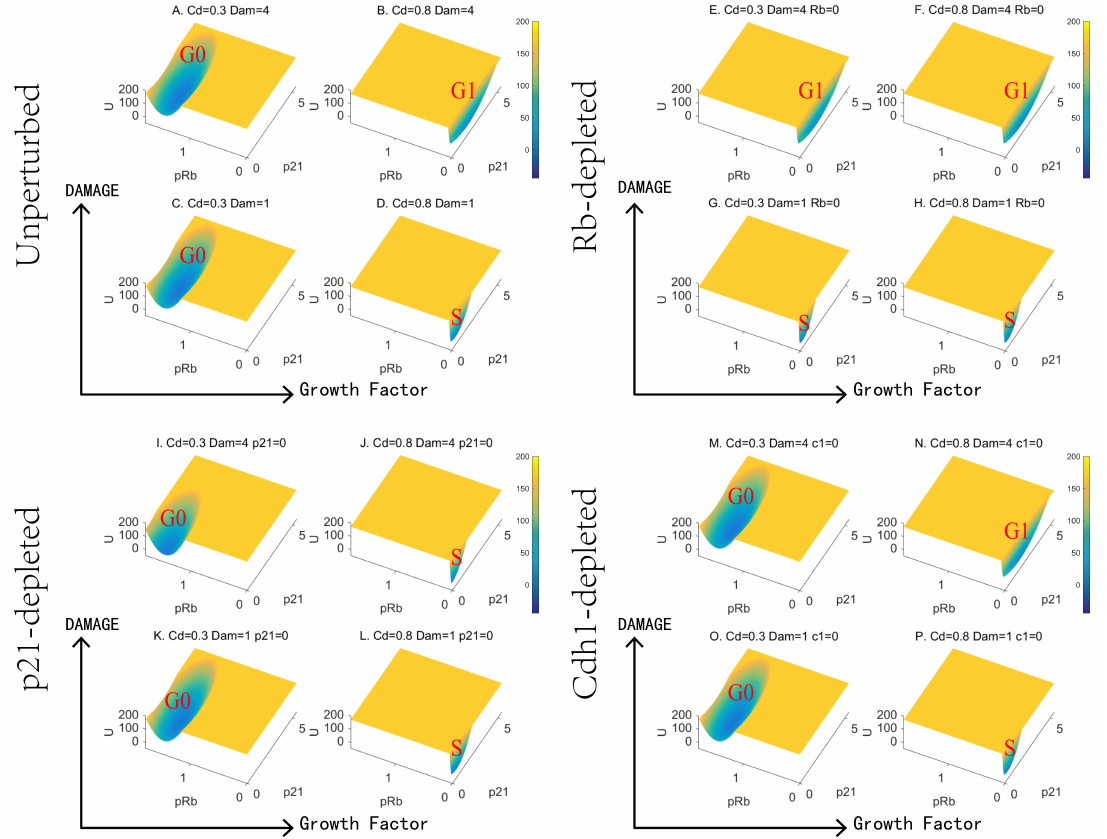
Figure 4. Landscape changes as growth factor and DNA damage change at different conditions. ( A – D ) Landscape of the proliferation–quiescence decision for an unperturbed system. ( E – H ) Landscape with Rb depletion. ( I – L ) Landscape with p21 depletion. ( M – P ) Landscape with Cdh1 depletion. The DNA damage level increases from bottom to top and the growth factor induced by CycD increases from left to